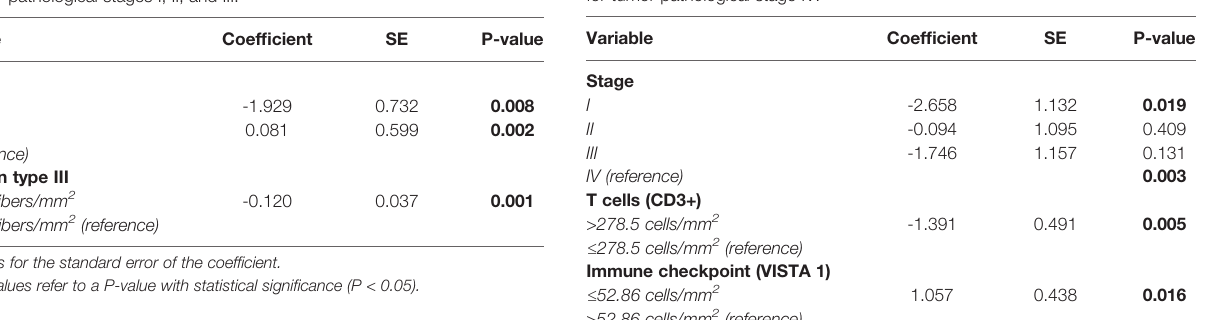
TABLE 3B | Cox proportional hazard model analysis of survival time, controlled for tumor pathological stage